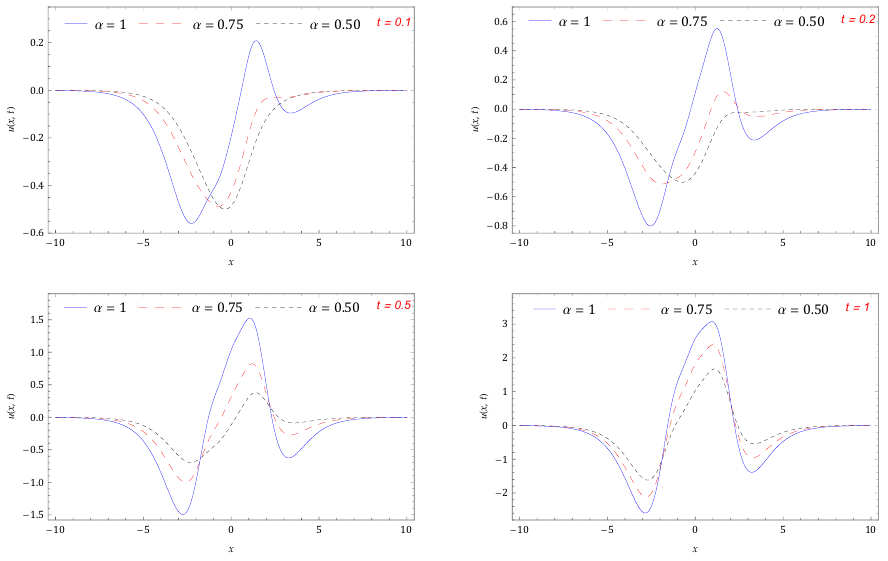
Figure 3. Response of obtained solution with distinct α and time at n = 1 , (cid:125) = − 1 , β = 2 and F r = −